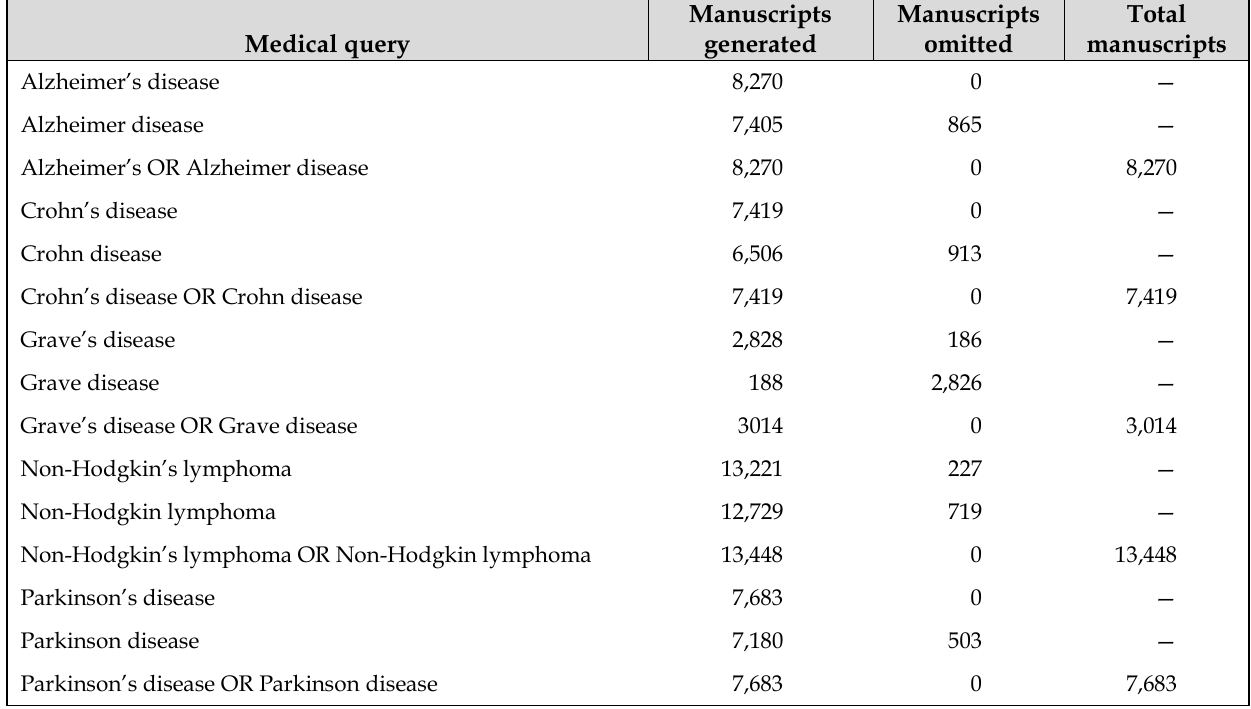
Table 1 Results of PubMed search queries for medical